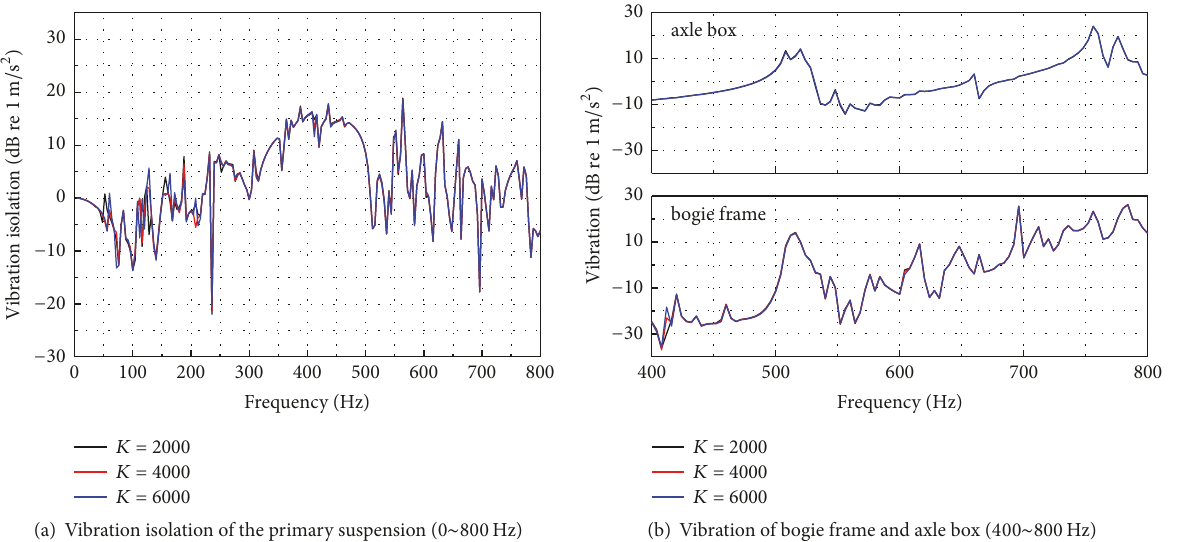
Figure 14: Different stiffness of the rubber bearing under coil